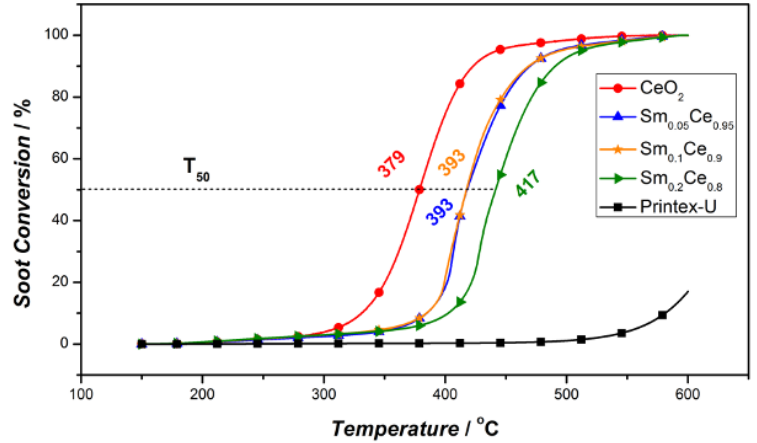
Figure 5. Soot conversion activity test of fresh Sm-doped ceria